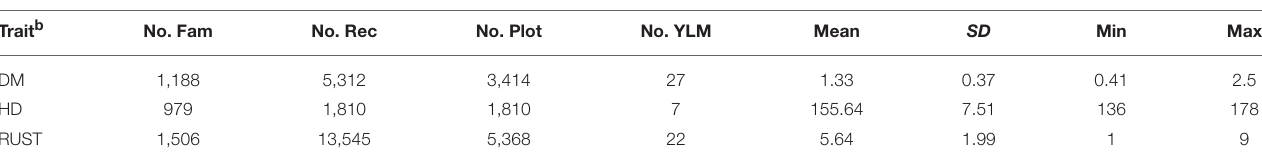
TABLE 1 | Descriptive statistics a for three traits. Trait